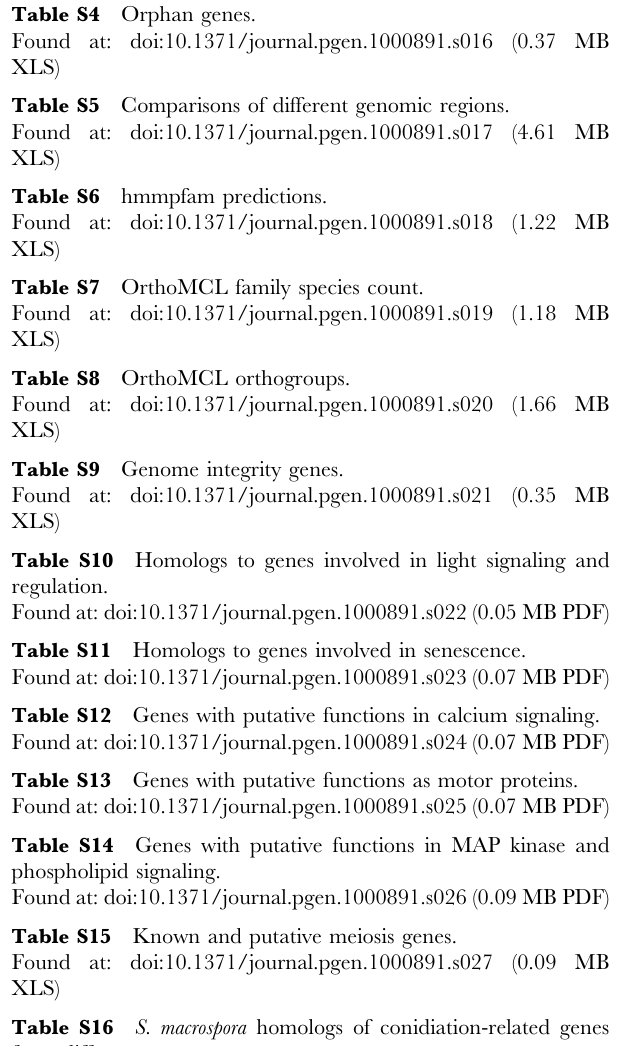
Table S16 S. macrospora homologs of conidiation-related genes from different ascomycetes. Table S17 S. macrospora homologs of genes involved in Table S18 Predicted polyketide synthases (PKS), non-ribosomal peptide synthases (NRPS), and fatty acid synthases (FAS). Table S19 A putative polyketide biosynthesis cluster that is partly conserved in S. macrospora and Phaeosphaeria nodorum